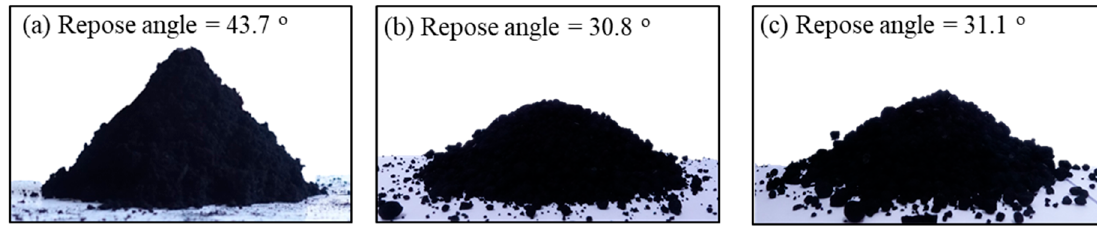
Figure 5. Images of the repose angle: ( a ) MWCNT, ( b ) case I and ( c ) case II.